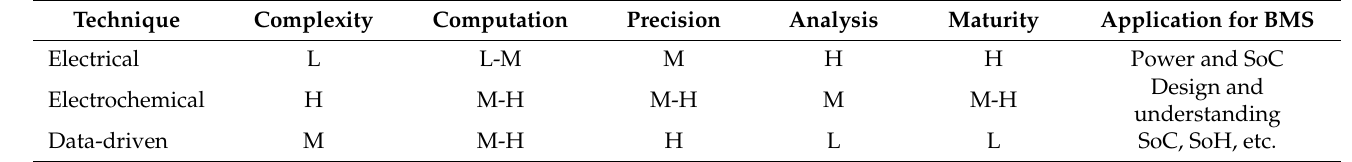
Table 3. Battery modeling techniques with their suitable applications.